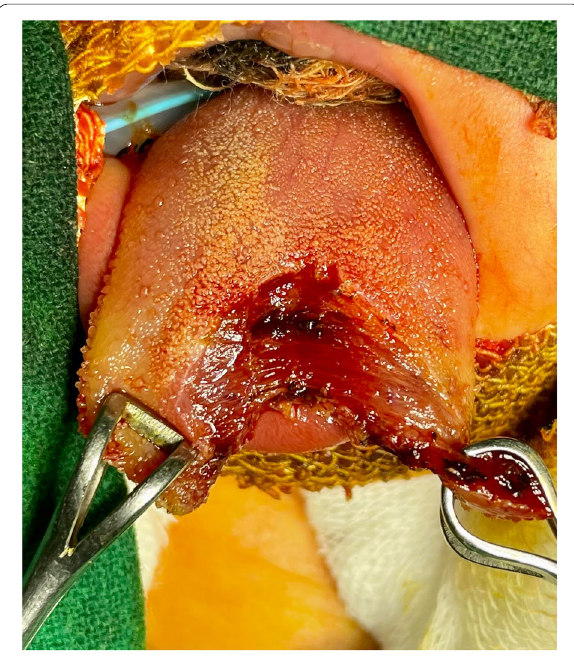
Fig. 3 Preoperative photo following excision of the mass